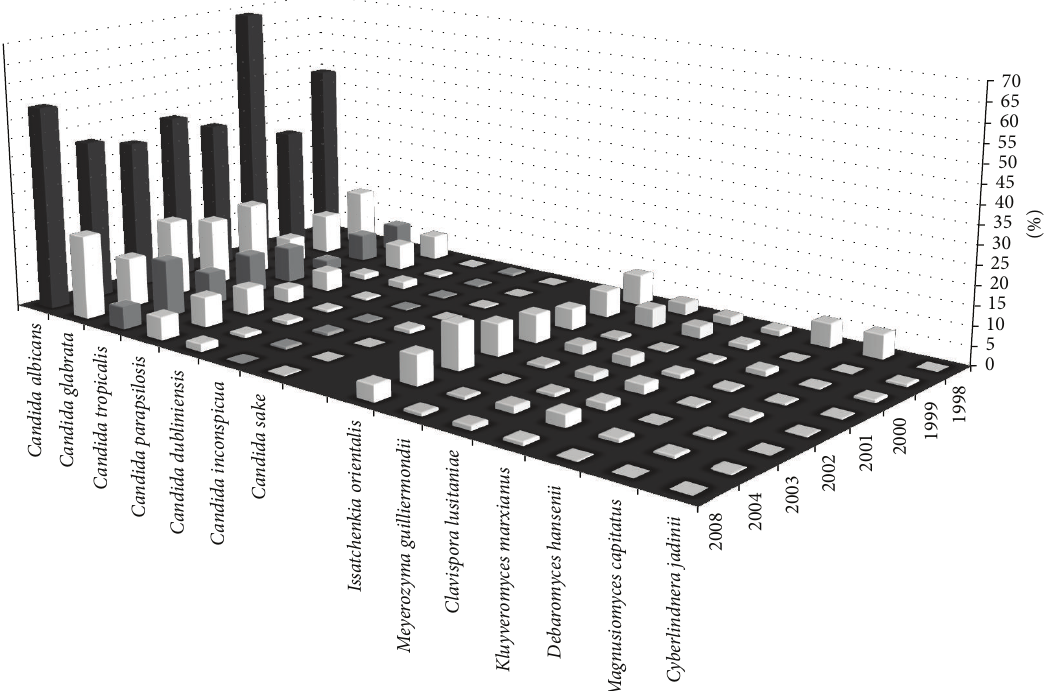
Figure 1: Distribution of the most frequently isolated DGP-related Candida and non- Candida species from 1998 to 2008.